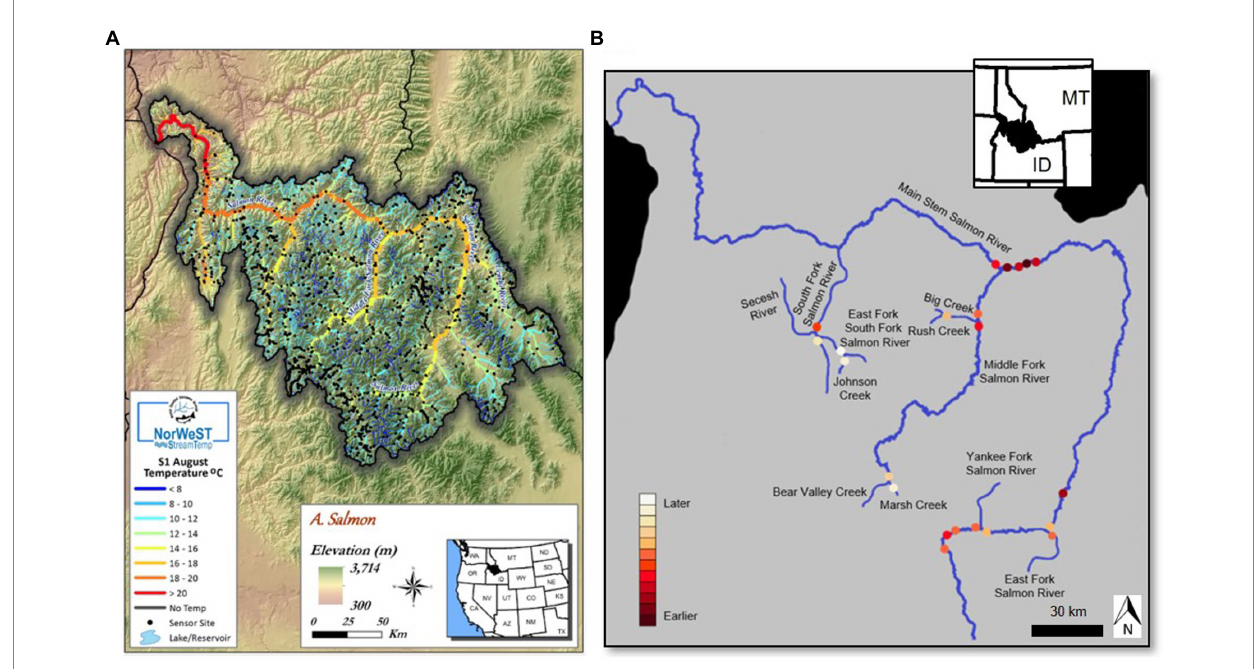
FIGURE 3 (A) Map of thermal heterogeneity in the Salmon River Basin, Idaho, United States, based on mean August temperatures from 1993 to 2011 (NorWeST temperature model; Isaak et al., 2017). (B) Salmonfly emergence across space and time in the Salmon River Drainage, Idaho, United States in June 2018. The color scale indicates the occurrence of emergence in 2018 from earliest (June 1st) to latest (June